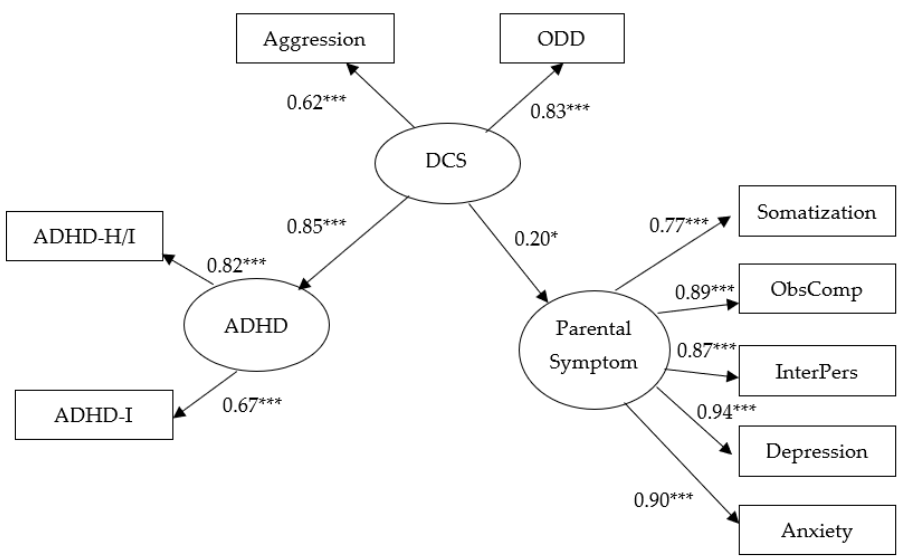
Figure 2. The SEM model (positing the direct effect model of DCS on ADHD and SCL). Circles represent unobserved latent variables. Rectangles represent observed measured variables. Values are standardized path coefficients. DCS Disruptive Child Symptom; ObsComp: Obsessive compulsive;